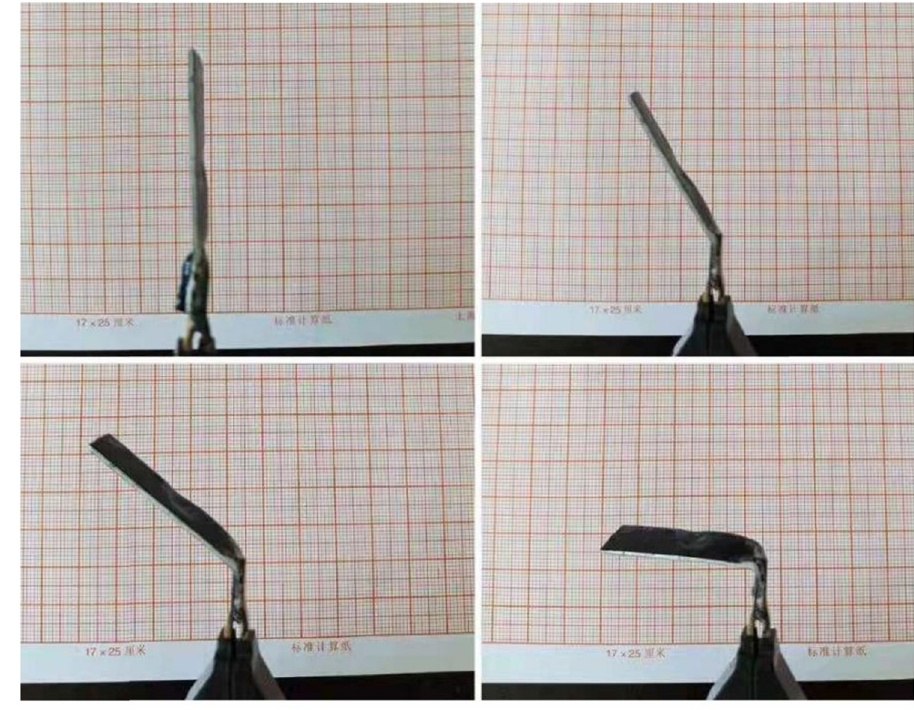
Figure 8: De fl ection and displacement diagram of electric brake with a frequency of 0.2 Hz and a voltage of 20